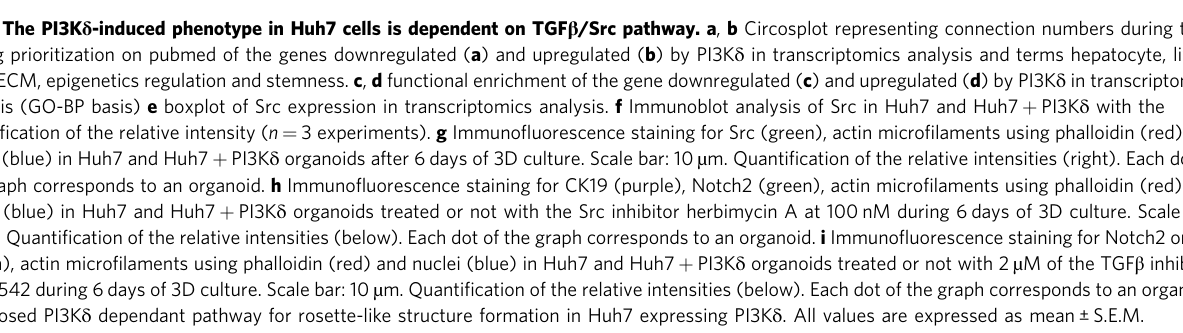
Fig. 3 The PI3K δ -induced phenotype in Huh7 cells is dependent on TGF β /Src pathway. a , b Circosplot representing connection numbers during text- mining prioritization on pubmed of the genes downregulated ( a ) and upregulated ( b ) by PI3K δ in transcriptomics analysis and terms hepatocyte, liver, EMT, ECM, epigenetics regulation and stemness. c , d functional enrichment of the gene downregulated ( c ) and upregulated ( d ) by PI3K δ in transcriptomics analysis (GO-BP basis) e boxplot of Src expression in transcriptomics analysis. f Immunoblot analysis of Src in Huh7 and Huh7 + PI3K δ with the quanti fi cation of the relative intensity ( n = 3 experiments). g Immuno fl uorescence staining for Src (green), actin micro fi laments using phalloidin (red) and nuclei (blue) in Huh7 and Huh7 + PI3K δ organoids after 6 days of 3D culture. Scale bar: 10 µ m. Quanti fi cation of the relative intensities (right). Each dot of the graph corresponds to an organoid. h Immuno fl uorescence staining for CK19 (purple), Notch2 (green), actin micro fi laments using phalloidin (red) and nuclei (blue) in Huh7 and Huh7 + PI3K δ organoids treated or not with the Src inhibitor herbimycin A at 100 nM during 6 days of 3D culture. Scale bar: 10 µ m. Quanti fi cation of the relative intensities (below). Each dot of the graph corresponds to an organoid. i Immuno fl uorescence staining for Notch2 or Src (green), actin micro fi laments using phalloidin (red) and nuclei (blue) in Huh7 and Huh7 + PI3K δ organoids treated or not with 2 µ M of the TGF β